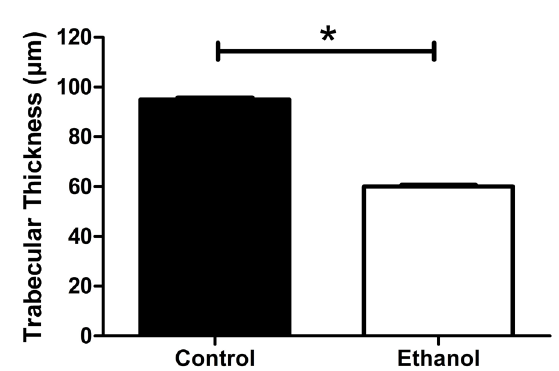
Figure 3. Thickness of the trabeculae of the proximal metaphysis of the femurs of rats in the control group (GC) and the alcohol intake group (GA); Student t test ; *asterisk indicates significant difference